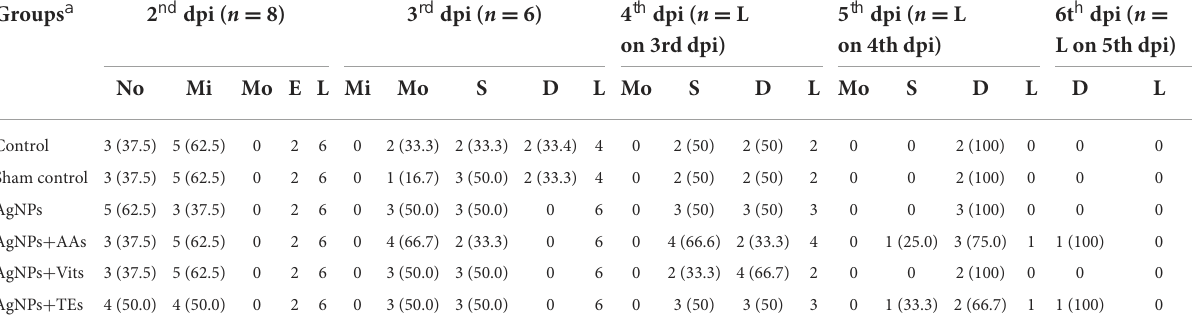
TABLE 5 Effect of in ovo administration of silver nanoparticles (AgNPs) and critical nutrients on classification of clinically ill birds on the basis of degree of severity (dpi wise) in treatment groups of unvaccinated birds. Groups